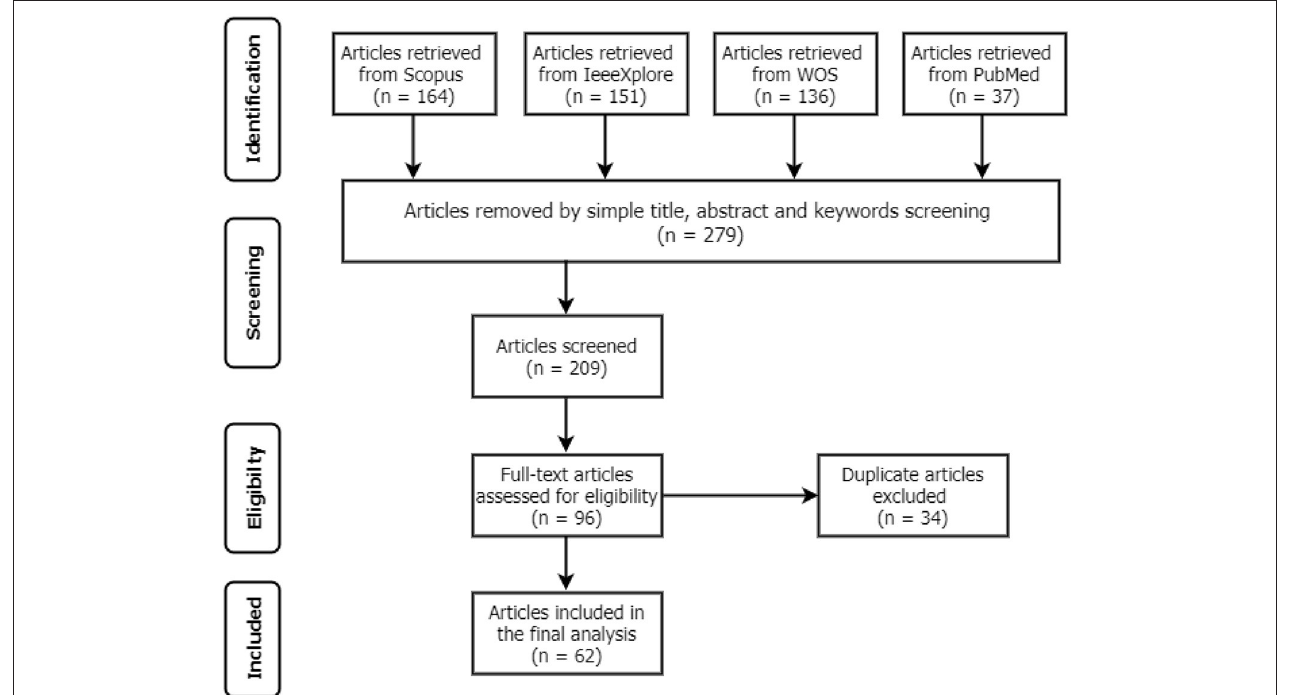
FIGURE 1 | The PRISMA structure for the study selection